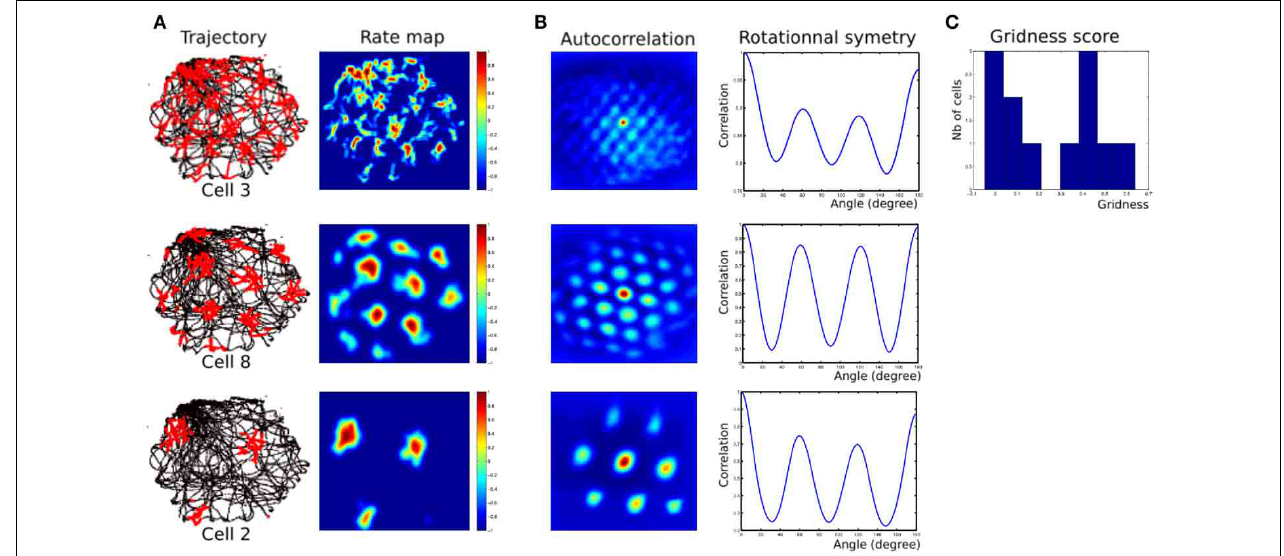
FIGURE 14 | (A) Firing field of grid cells with 3 different spatial frequencies (one cell from each layer). Left row, robot path (black) with superimposed grid cell activity (red); right row, rate-coding map (obtained by a gaussian convolution on cell activity). Red = 1 , dark-blue = 0 . (B) Periodic structure of grid cells activity shown in panel (A) . Left row, autocorrelation matrix for the rate map. The color scale is from blue = − 1 (anticorrelated) through green = 0 (no correlation) to red = 1 (fully correlated). Distance scales are 4 times bigger